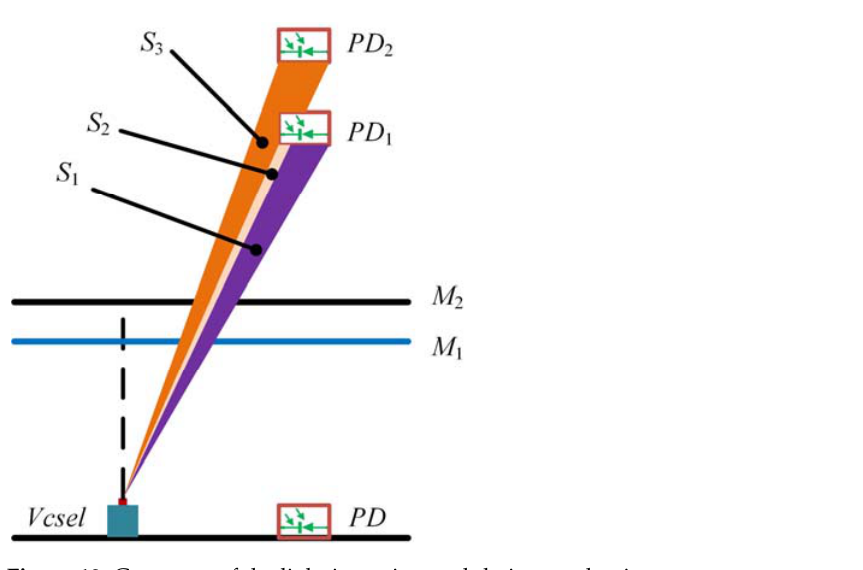
Figure 10. Geometry of the light intensity modulation mechanism.